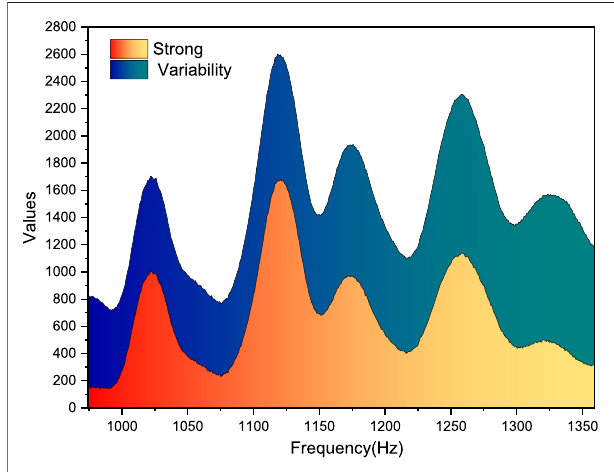
FIGURE 9 | Power spectrum of the broad fascial tensor muscle for the four